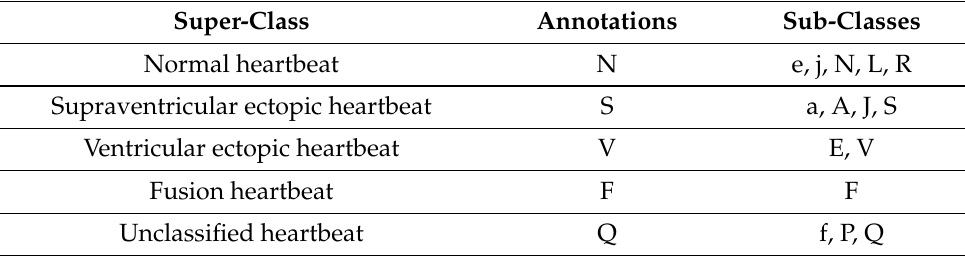
Table 7. MIT-BIH Arrhythmia Dataset (D2) Sub-class